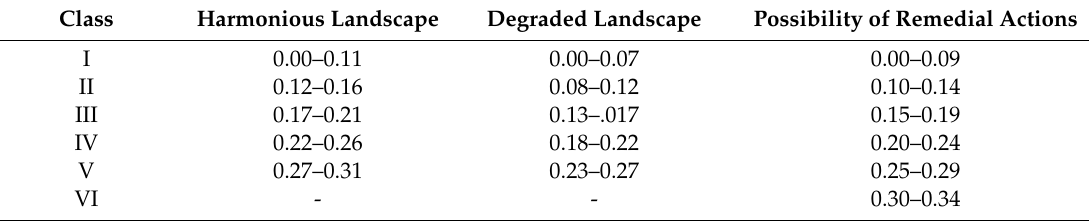
Table 2. Classification of the assessment of the harmonious landscape, the degraded landscape and the possibility of remedial